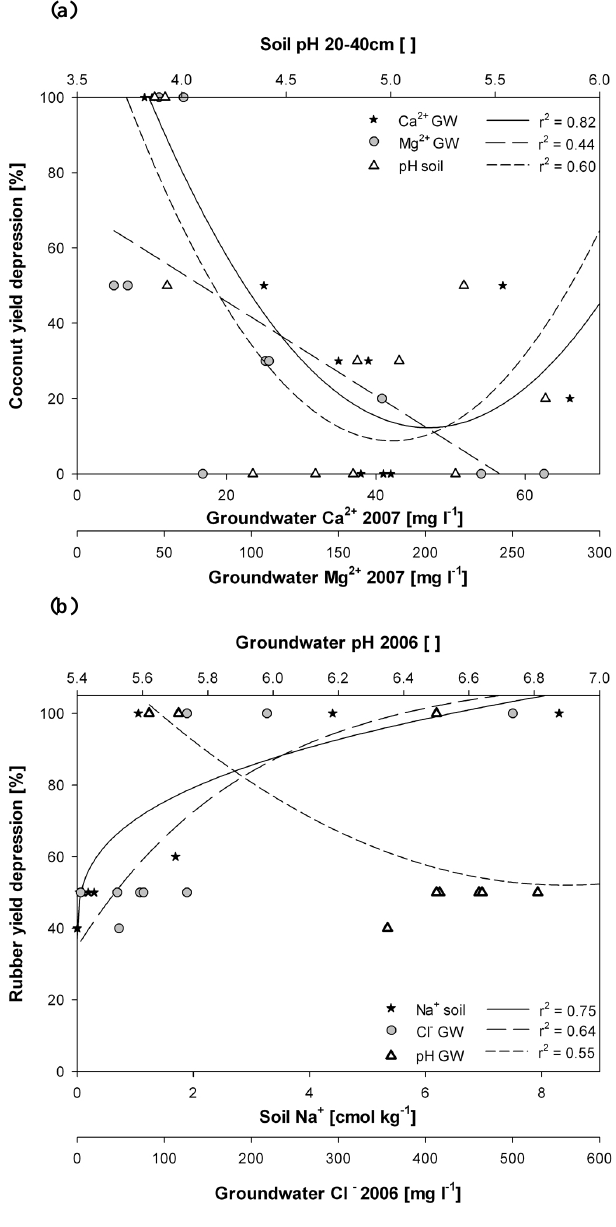
Fig. 7. Response of yield depression in coconut (a) and rubber (b) to soil and groundwater